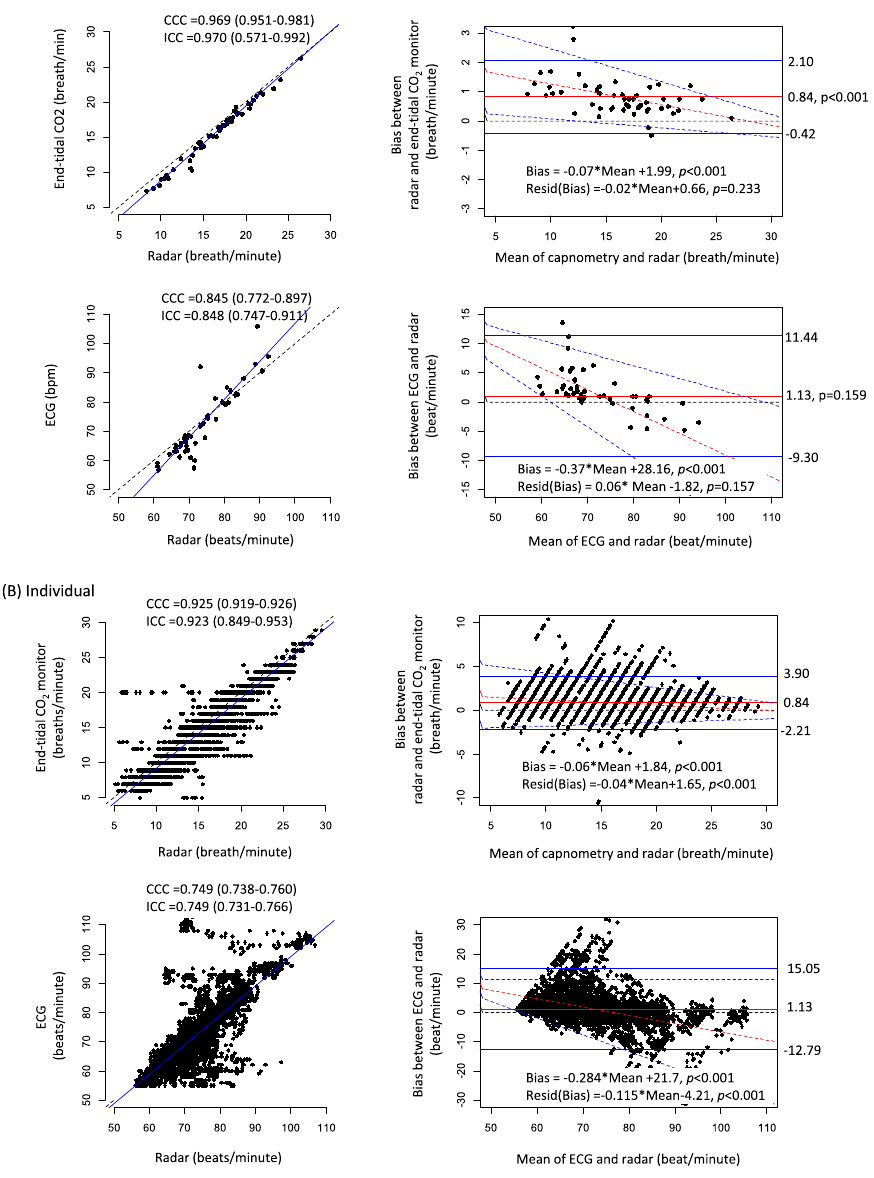
Figure 4. Agreements between RRs and HRs measured using IR-UWB radar and those measured using the conventional patient monitor. ( A ) Agreements of mean RR and HR. ( B ) Agreements of individual RR and HR. The blue solid lines in scatter plots indicates estimates of linear regression models. The blue solid lines in Bland–Altman plots indicate 95% upper and lower LOAs and the red solid lines indicate the mean biases. The red broken lines represent the estimates of linear regression models between the bias and the mean values and the blue broken lines represent the 95% prediction intervals of the biases corresponding to the mean values. Resid(Bias) residuals of biases between radar and the conventional